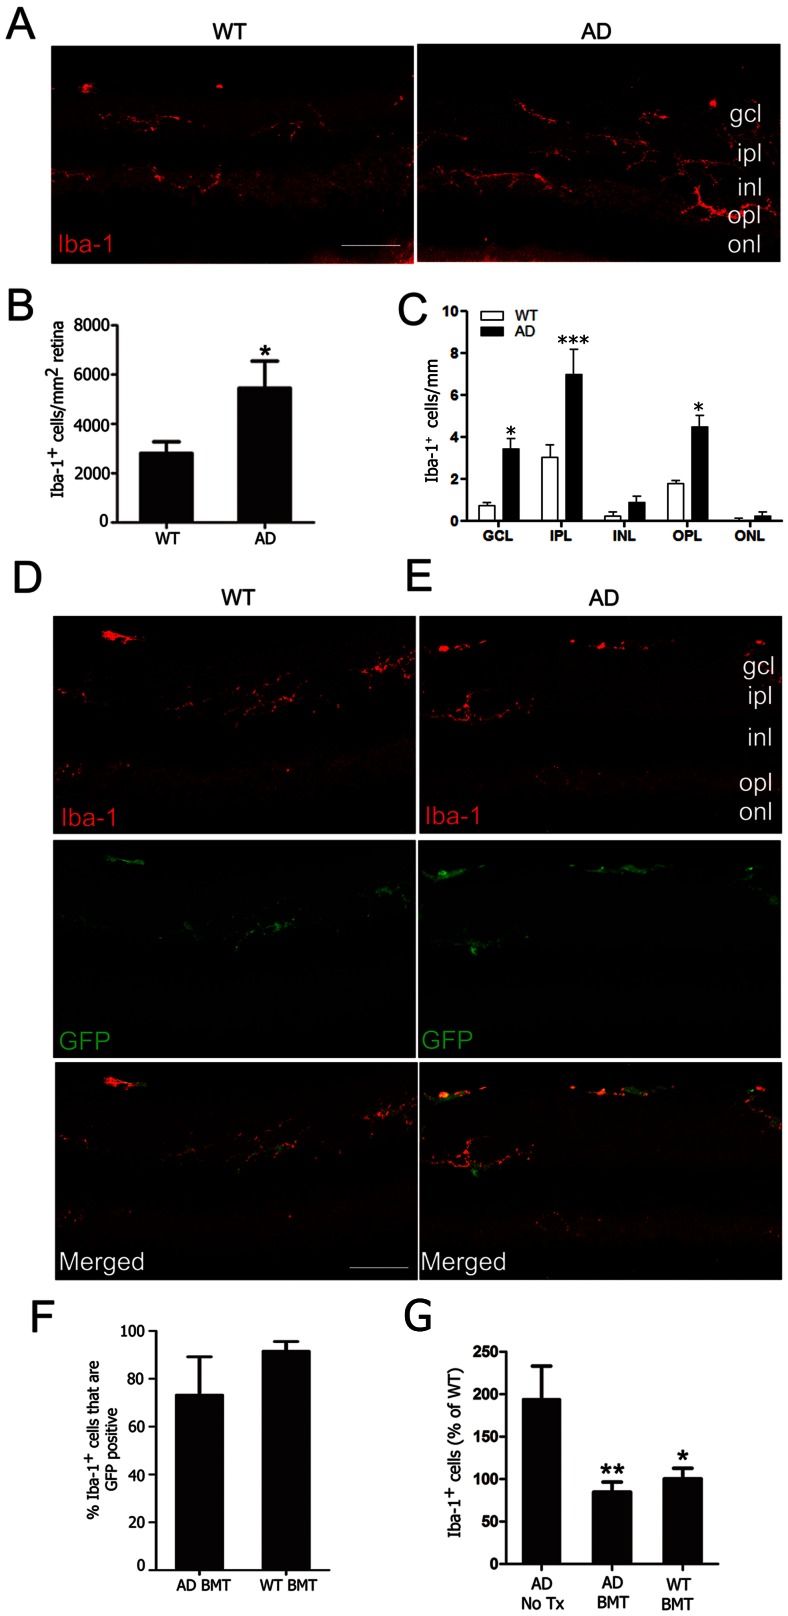
Increased microglia density in experimental AD is mitigated by BMT.
A: Representative retinal cryosections from wt (left) and APPswe-PS1ΔE9 mice (right) were stained with anti-Iba-1 antibody and visualized with Cy3-conjugated secondary antibody. Ramified microglia were primarily identified in ganglion cell layer (gcl), inner plexiform layer (ipl) and outer plexiform layer (opl) in wt and APPswe-PS1ΔE9 retinas. B: Unbiased stereologic analysis revealed increased microglia density in control (untreated) APPswe-PS1ΔE9 retina compared with wt control mice (*P<0.05, n = 7–9, student's t test). C: Average Iba-1+ microglia density in the different retinal layers. Significantly higher numbers of Iba-1+ microglia were noted in gcl, ipl and opl in APPswe-PS1ΔE9 mice (*P<0.05, ***P<0.001, n = 7–9, two-way ANOVA followed by Bonferroni post test.) Confocal images from wt (D) and APPswe-PS1ΔE9 (E) retinas immunostained with Iba-1 (red) demonstrate that BM-derived GFP+ cells (green) exhibited ramified microglia morphology and had near-uniform expression of Iba-1. In both wt and APPswe-PS1ΔE9 BMT recipient mice, host microglia were almost completely replaced with BM-derived cells. F: Unbiased stereologic quantitation of retinal microglia engraftment revealed 91.2±4.0% of wt and 73.2±16.0% of APPswe-PS1ΔE9 Iba-1+ microglia were BM derived (GFP+). G: Microglia density in retina of wt BMT recipients was not different from non-transplanted wt mice, but BMT in APPswe-PS1ΔE9 mice normalized microglia density to wt levels. Data are percent of wt Iba-1+ cells/mm2 in non-transplanted APPswe-PS1ΔE9 untreated mice (AD no Tx) or APPswe-PS1ΔE9 and wt BMT recipients (*P<0.05, **P<0.01, n = 6–10, one-way ANOVA followed by Bonferroni post test). Scale bars  = 30 μm.